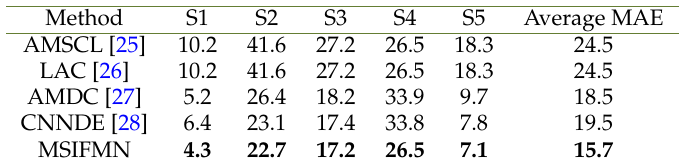
Table 4. Average MSE comparison for Worldexpo10